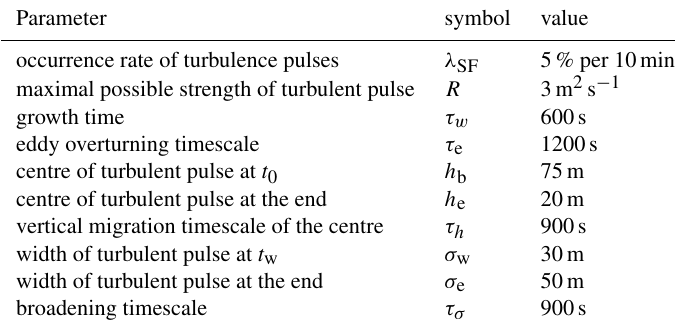
Table 5. Values for the free parameters in the stochastic forcing parameterization as used in the SCM experiment. Parameter symbol value occurrence rate of turbulence pulses λ SF 5% per 10min maximal possible strength of turbulent pulse R 3m 2 s − 1 growth time τ w 600s eddy overturning timescale τ e 1200s centre of turbulent pulse at t 0 h b 75m centre of turbulent pulse at the end h e 20m vertical migration timescale of the centre τ h 900s width of turbulent pulse at t w σ w 30m width of turbulent pulse at the end σ e 50m broadening timescale τ σ